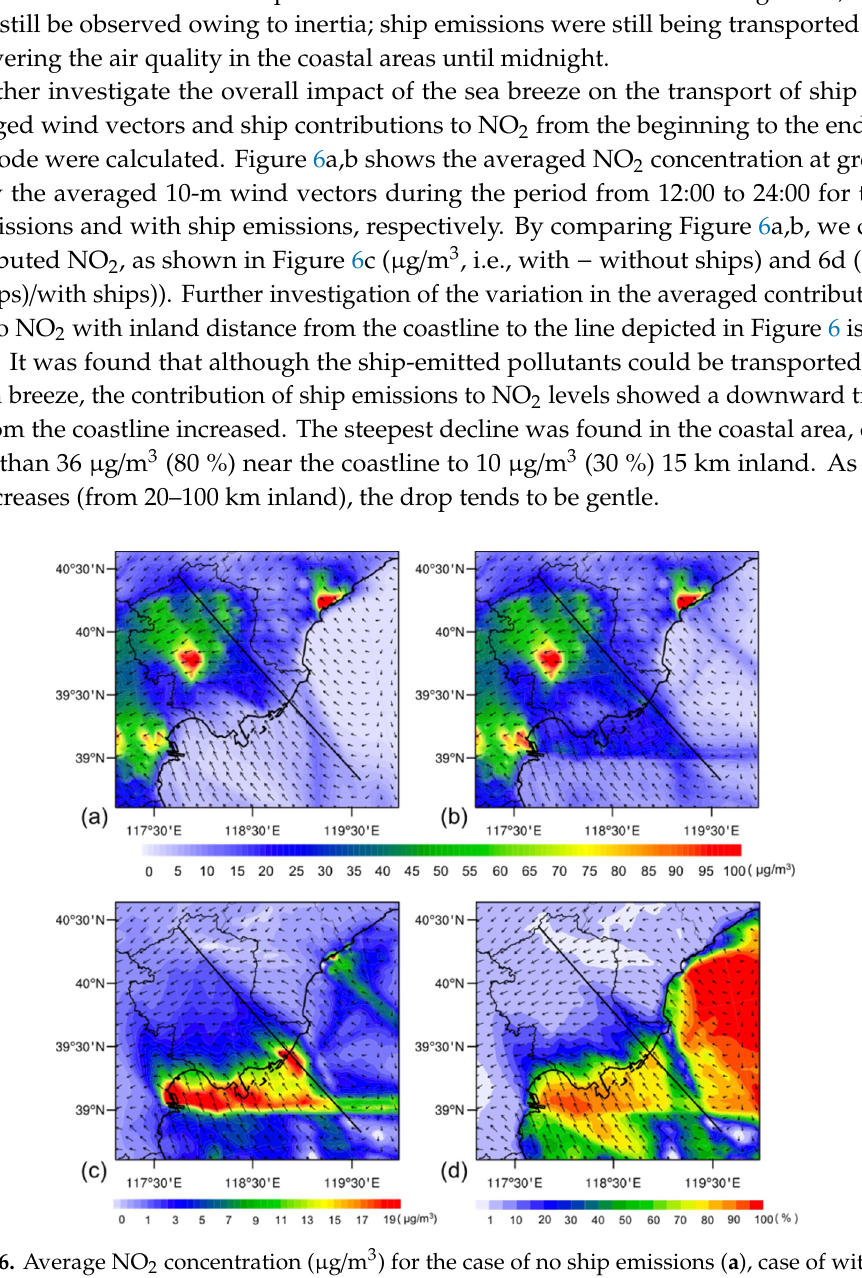
Figure 7. Variation of the averaged ship-contributed NO 2 in µg/m 3 (blue curve) and in % (red curve) during the period from 12:00 to 24:00 at ground level with the distance from the coastline to inland along the black line depicted in Figure 6. Author Contributions: Methodology, D.C.; Validation, X.G., Y.Z. and J.L.; Formal Analysis, F.S.; Investigation, F.S.; Resources, Y.L.; Data Curation, Y.L.; Writing-Original Draft Preparation, F.S.; Writing-Review & Editing, D.C.; Visualization, F.S.; Supervision, X.F. Funding: This research was funded by National Natural Science Foundation of China (No. 51978011 & 51578017). Acknowledgments: The authors are grateful to the anonymous reviewers for their insightful comments. Conflicts of Interest: The authors declare no conflict of interest.